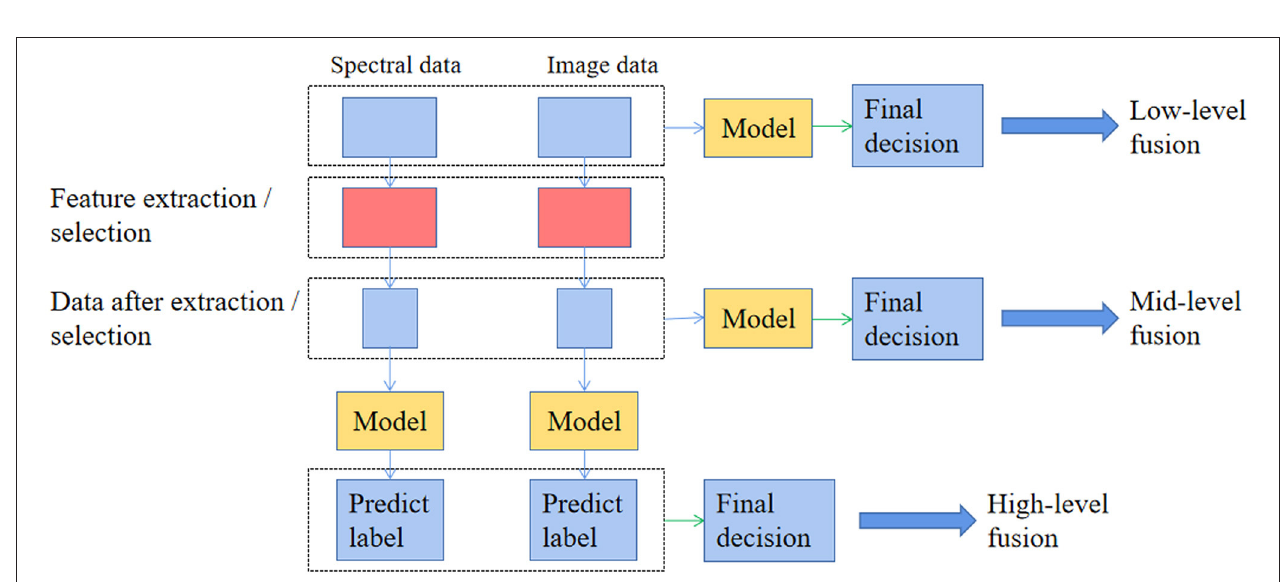
FIGURE 2 | The strategy for food varieties and geographical regions classification tasks.